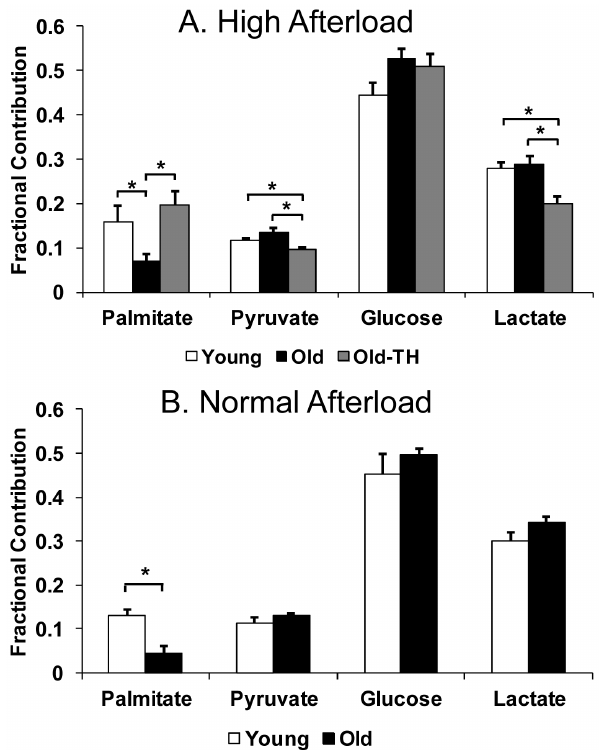
Figure 1. Fractional contribution (Fc) to the citric acid cycle for unlabeled substrates (predominately palmitate), pyruvate, glucose and lactate. (A) Young, Old and Old-TH at high afterload (n=7–9 per group). (B) Young and Old mice at standard afterload (n=4–5 per group). Values are means 6 SEM. *p , 0.05 between indicated groups.